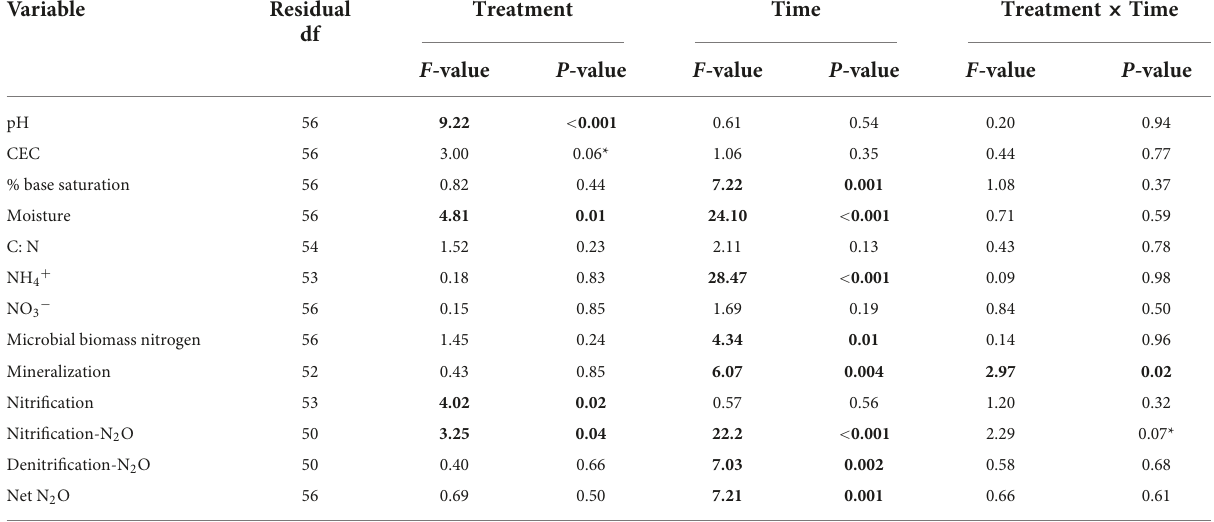
TABLE 1 F - and p -value results from 2-way mixed effects ANOVA models based on garlic mustard treatment, sampling time, and their interaction as fixed effects, with sampling site (forest) as a random effect.